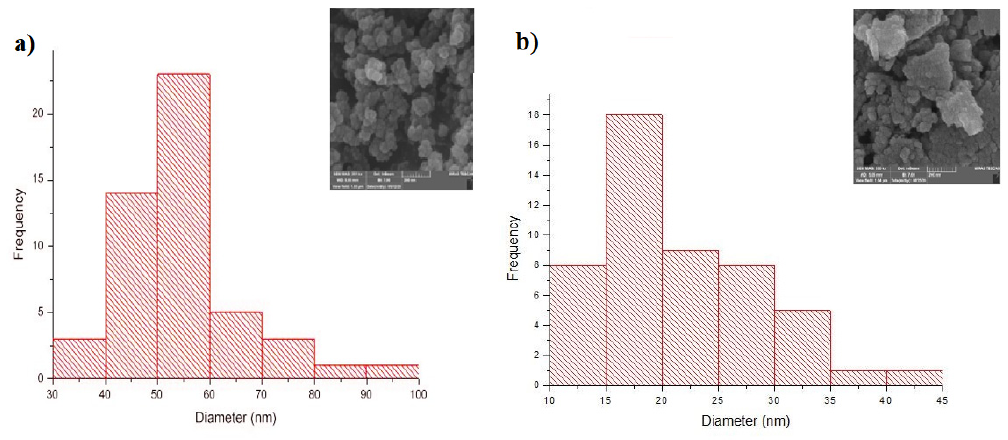
Fig. 4. The particle size distribution of a) RF, b)